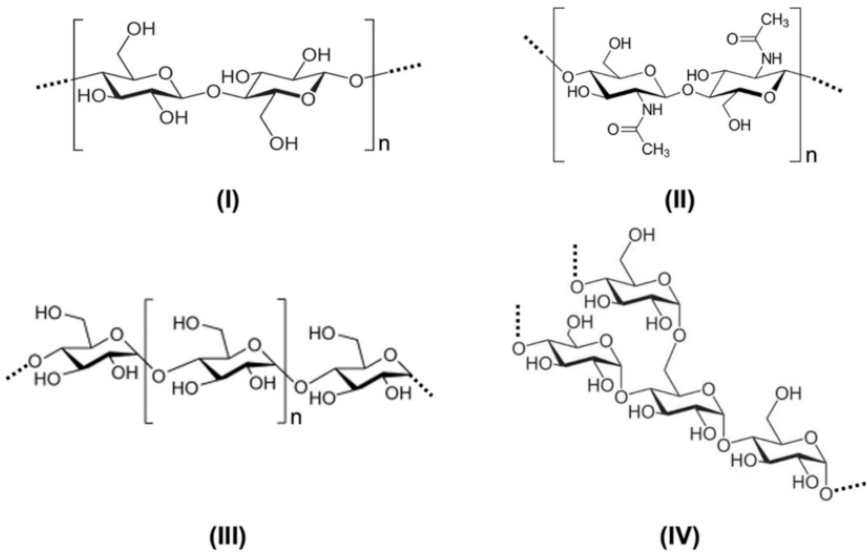
Figure 2. Molecular structures of cellulose ( I ), chitin ( II ), and of the two polysaccharides of starch, the linear amylose ( III ) and the branched amylopectin ( IV